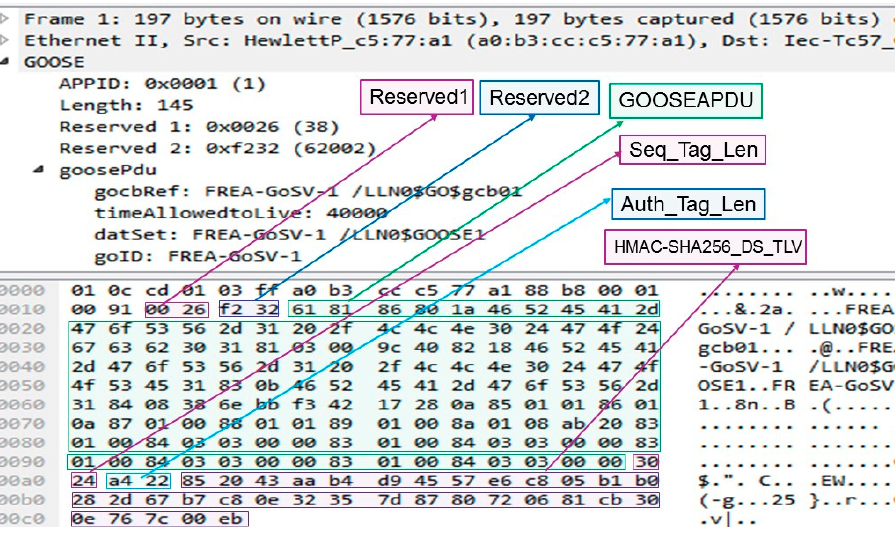
Figure 16. Wireshark capture of GOOSE frame with the extension of HMAC-SHA256 digital signature.